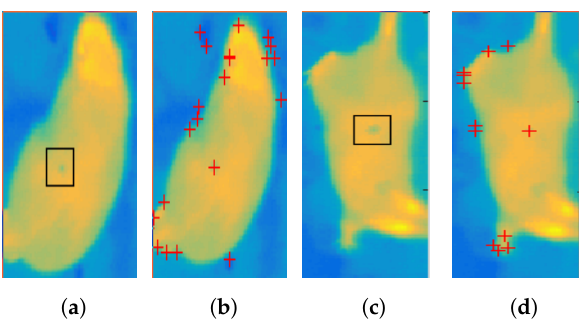
Figure 9. The results of Harris corner detector on the real images with simulated saliva trace of size ( a ) 2 pixels and ( c ) 3 pixels. The trace is marked with a black rectangle. Panels ( b , d ) are the detected corners are marked with red crosses.